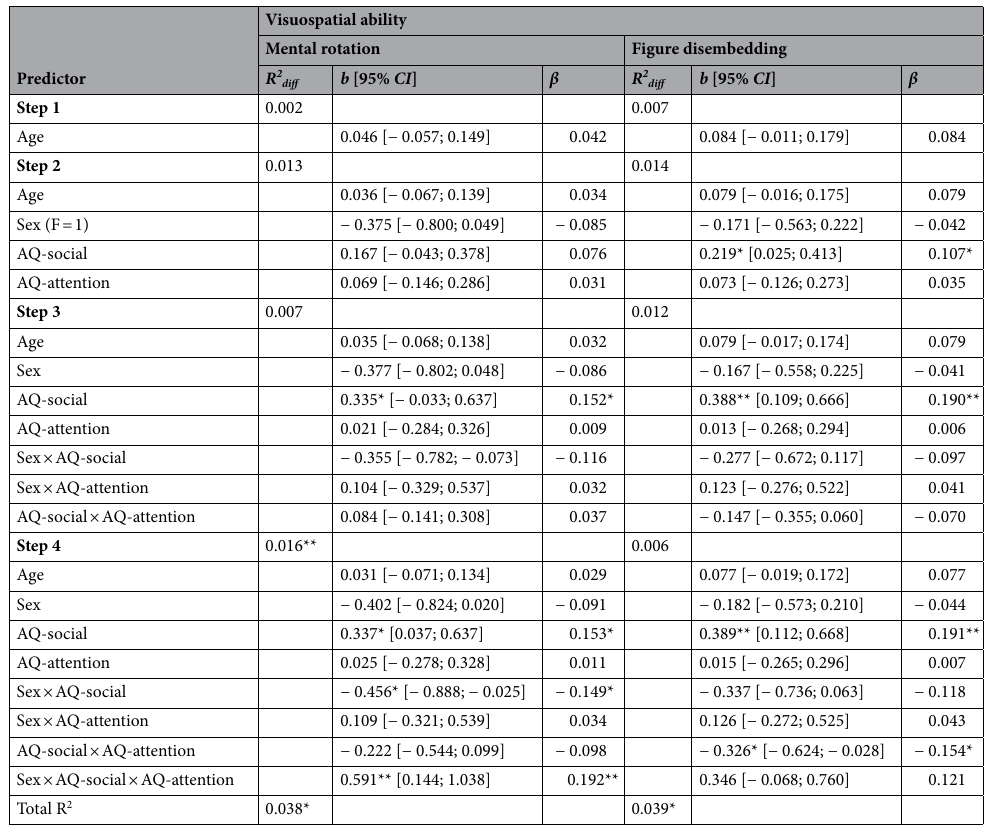
Table 3. Hierarchical multiple regression analyses predicting visuospatial abilities from age, sex, social and non-social autistic traits, and their interaction. N = 426. Age = age of participants in years (z-score); Sex = participants’ sex dummy coding (Men = 0; Women = 1); * p < 0.05; ** p < 0.01; *** p <